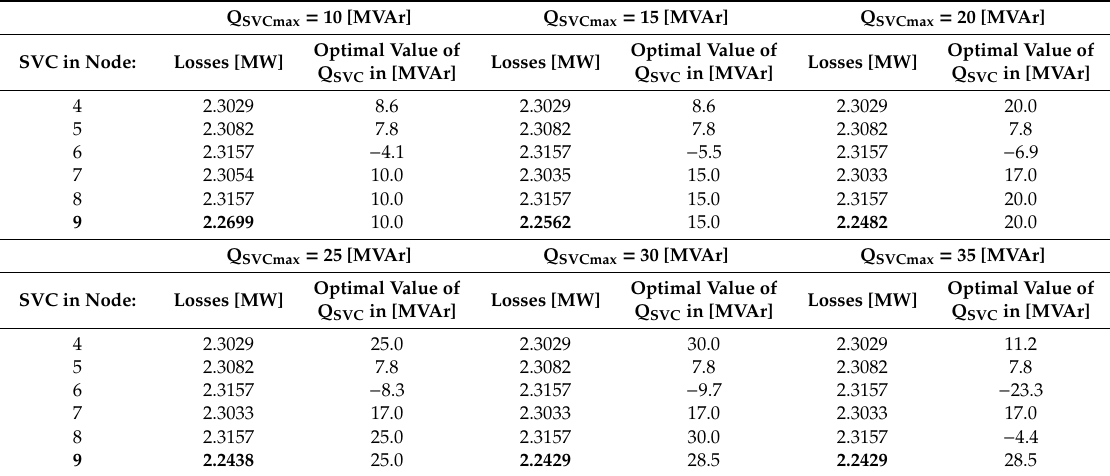
Table 4. Power losses (MW) with SVC in the IEEE 9 test bus system with a limited value of Q SVC —CASE 1.